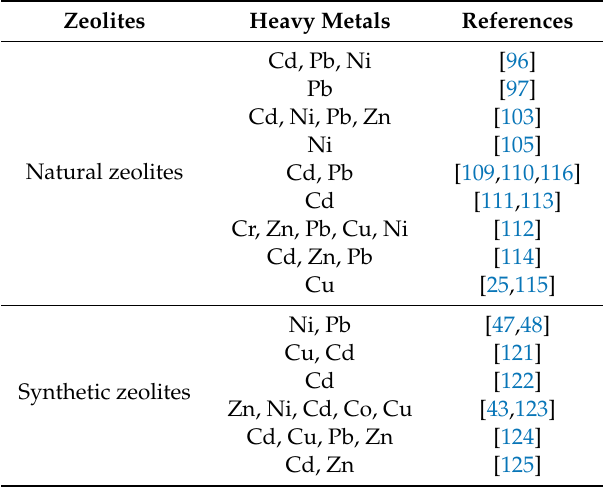
Table 2. Type of amendments for metals